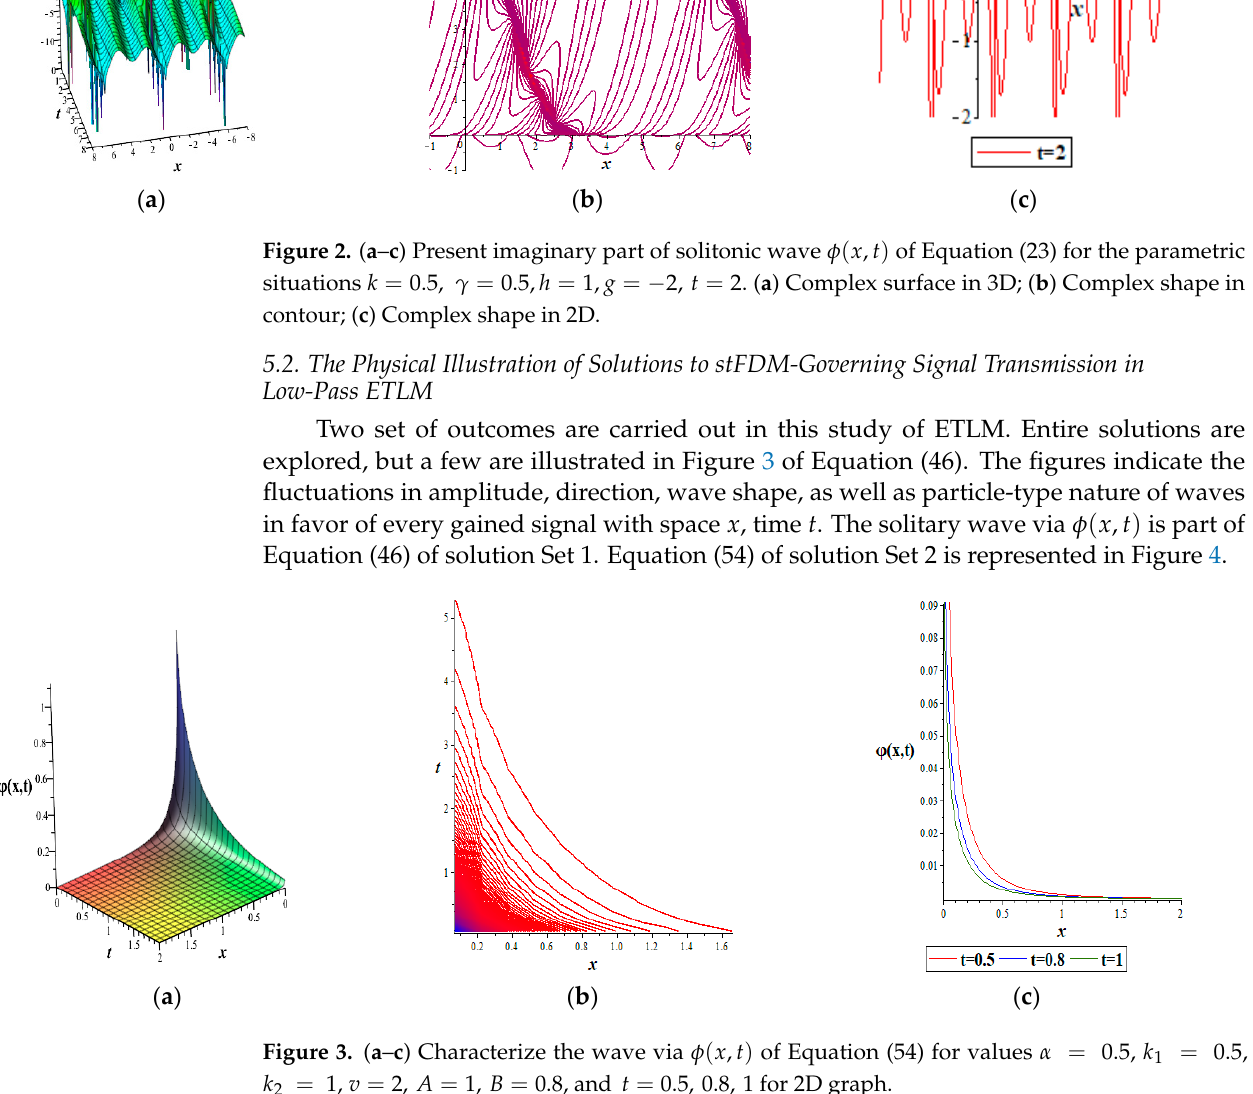
Figure 4. ( a – c ) Represent the imaginary part of wave via ),( tx metric situation 2,1,2,1,5.0,67.0 21